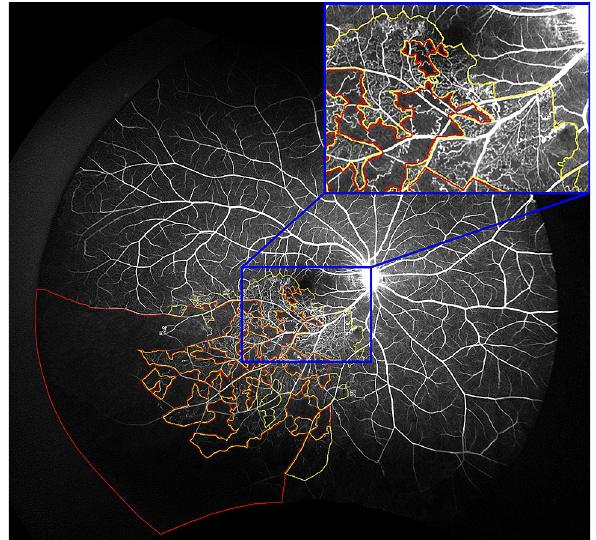
Figure 2. Ultra-widefield fluorescein angiogram of branch retinal vein occlusion with various non- perfusion status. Areas of partial ischemia (surrounded by yellow lines) show clusters of small fragmented areas of hypofluorescence with dilation and irregular capillary network patterns. Areas of complete ischemia (surrounded by red lines) show continuous area of hypofluorescence due to retinal capillary loss and obstruction of precapillary arterioles and postcapillary